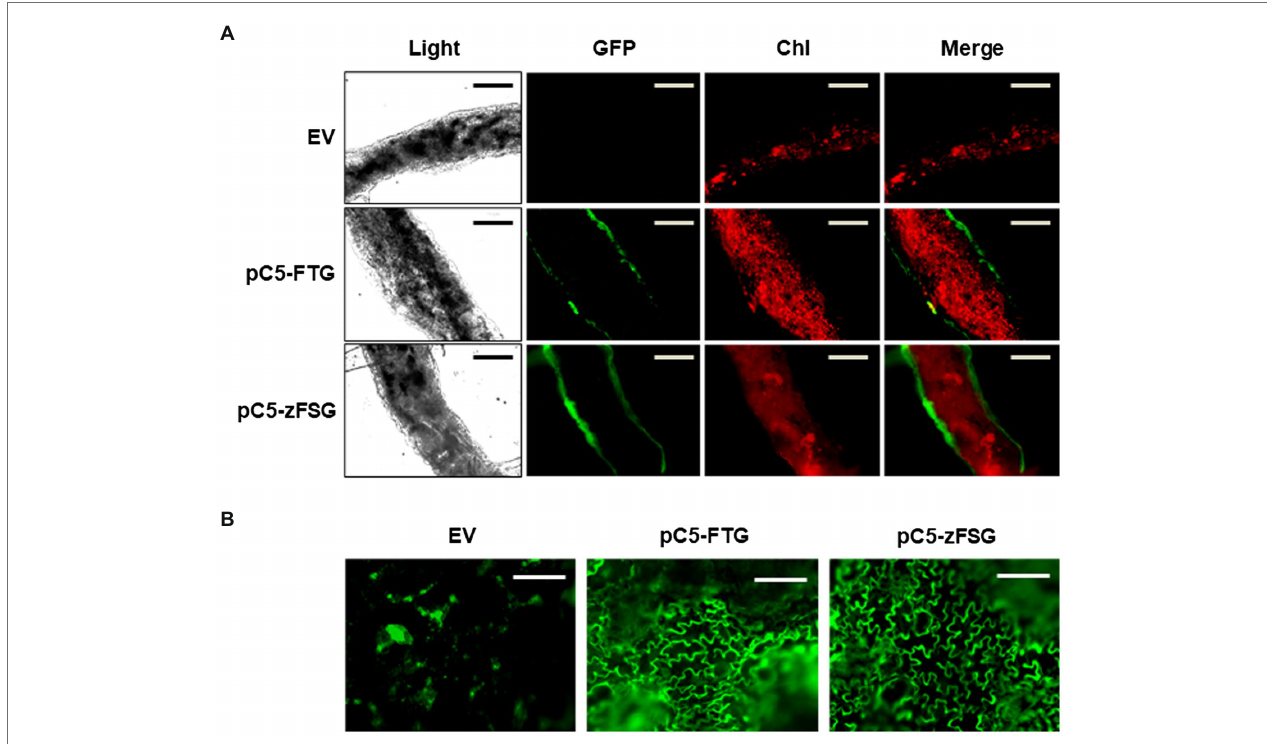
FIGURE 3 | Tissue-specific expression of the multicistronic constructs. Cross-sections (A) and surface sections (B) of tomato leaves infiltrated with Agrobacterium carrying the pC5-FTG construct, the pC5-zFSG construct, or the empty pMCS vector (EV) were analyzed by light and confocal laser scanning microscopy. Panels show fluorescence of green fluorescent protein (GFP) and chlorophyll autofluorescence (Chl). Scale bars represent 100 μ